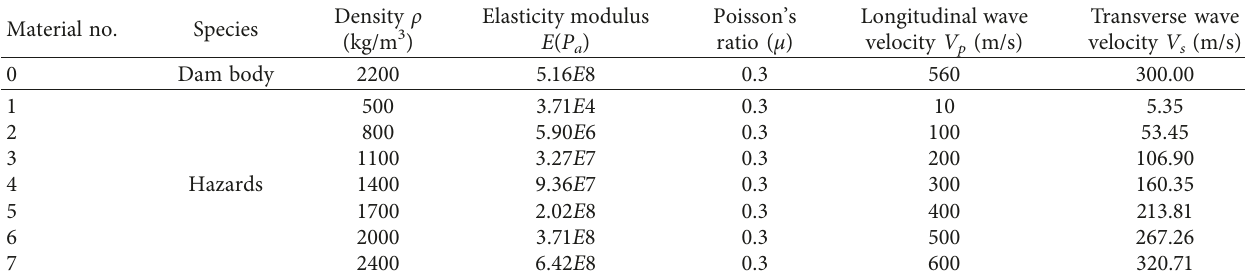
Figure 2: Schematic diagram for size of the finite element model of earth-rock dam with leakage passages. (a) Transverse section. (b) Longitudinal section. Table 1: Material parameters for three-dimensional finite element models.